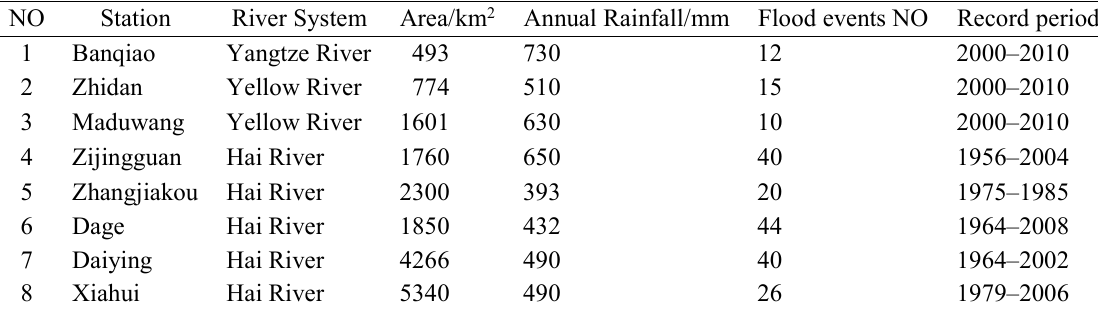
Table 1 Information and characteristics of the study